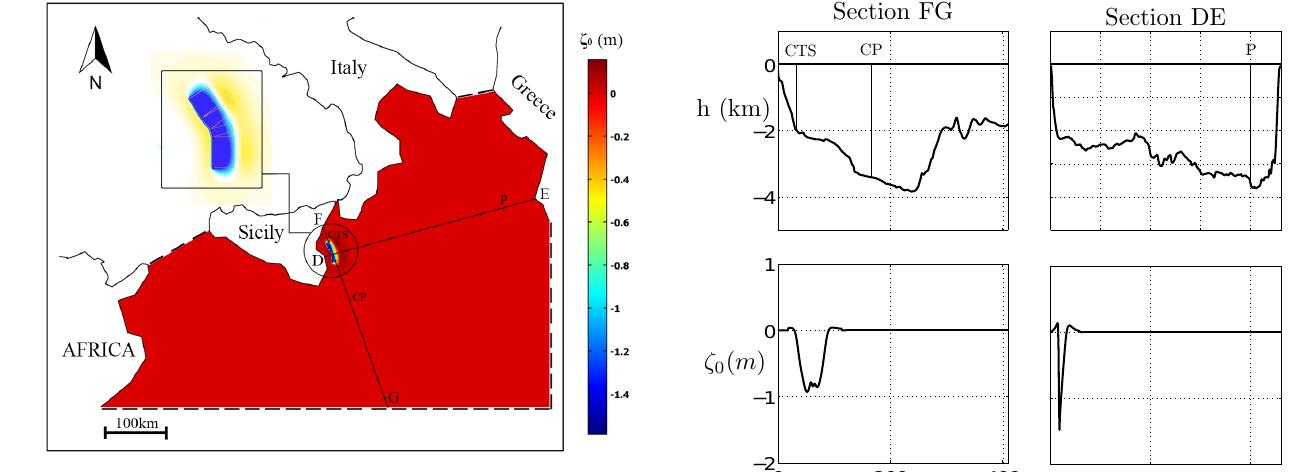
Figure 7. Residual vertical seabed dislocation, ζ 0 (m), for the 1693 Sicily earthquake, as reconstructed by Tonini et al. (2011)